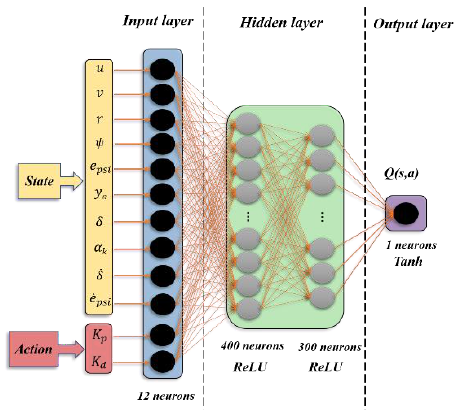
Figure 7. Critic network architecture.